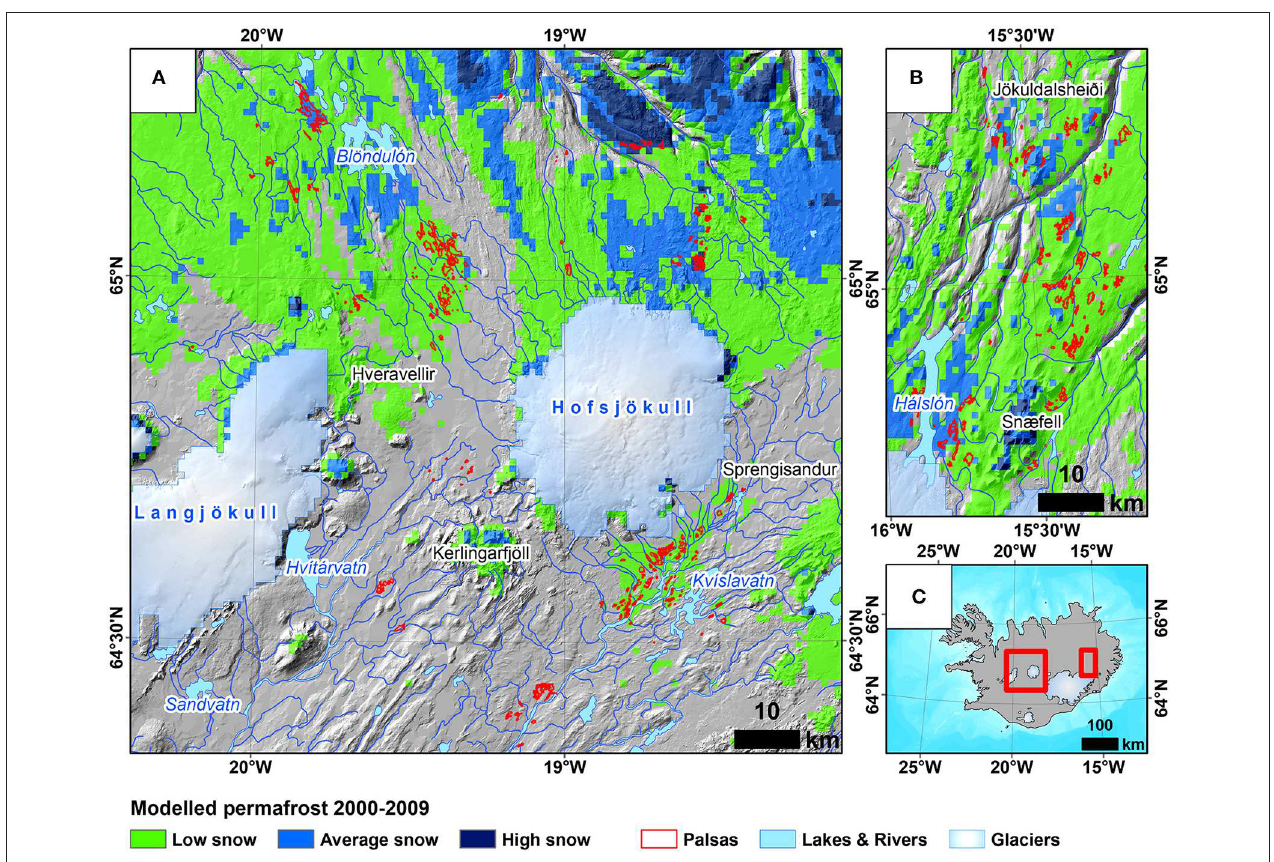
FIGURE 6 | Validation of the permafrost model simulations for the period 2000–2009 based on the palsa distribution in (A) west-central Iceland, (B) eastern Iceland. (C) Inset map showing the location of the west-central (A) and eastern (B) palsa areas. Modelled permafrost based on TTOP is shown (see Figure 9 for details). Palsa distribution data from the Icelandic Institute of Natural History. Map data from